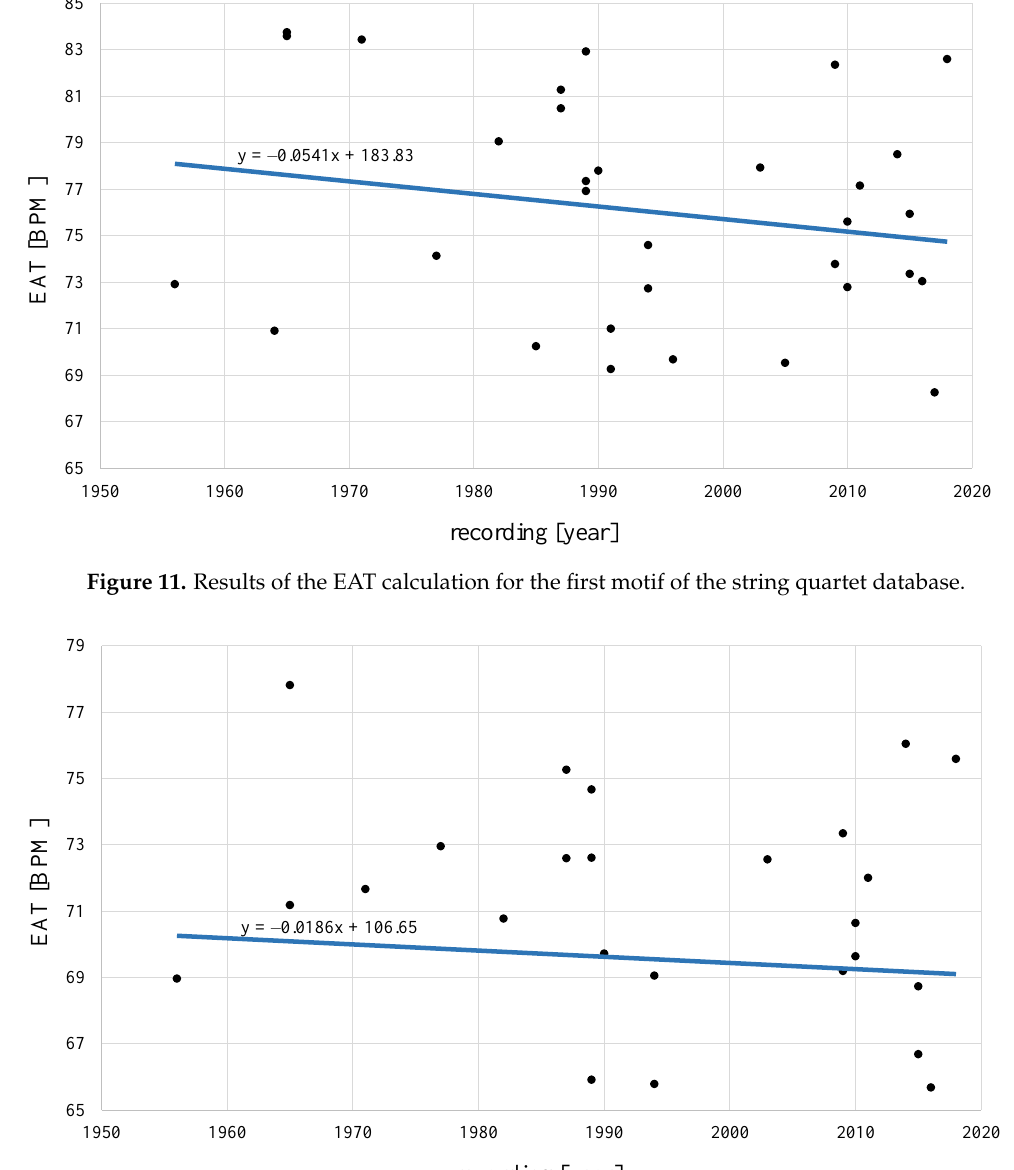
y = –0.0186x + 106.65